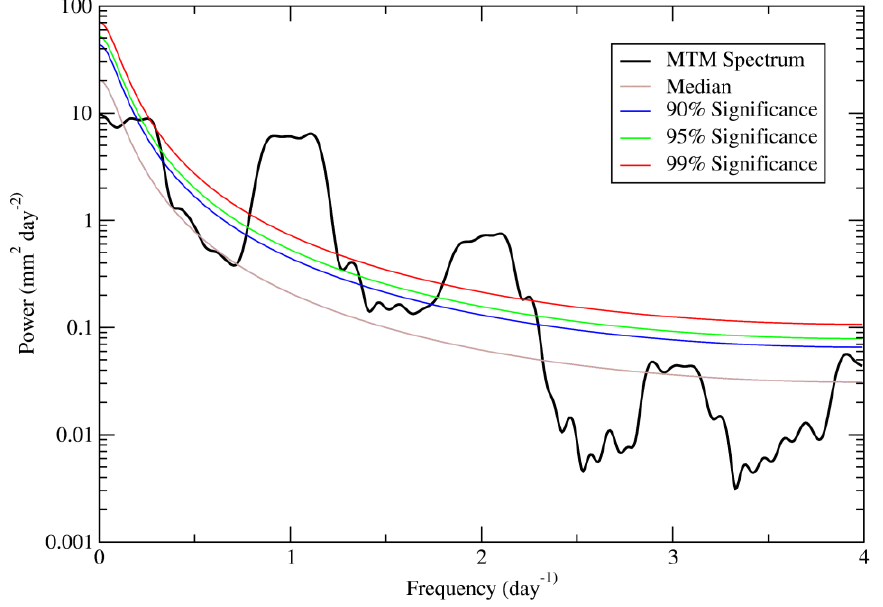
Figure 2. MTM power spectrum (p = 2, K = 3) of mean simulated precipitation over 22.2° N–32.9° N, 115.7° W–101.5° W during 1–10 July